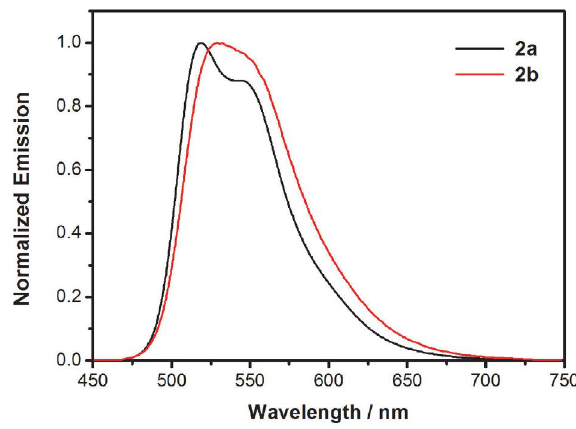
Fig. 3. The emission spectra of 2a–2b in CH 2 Cl 2 at room